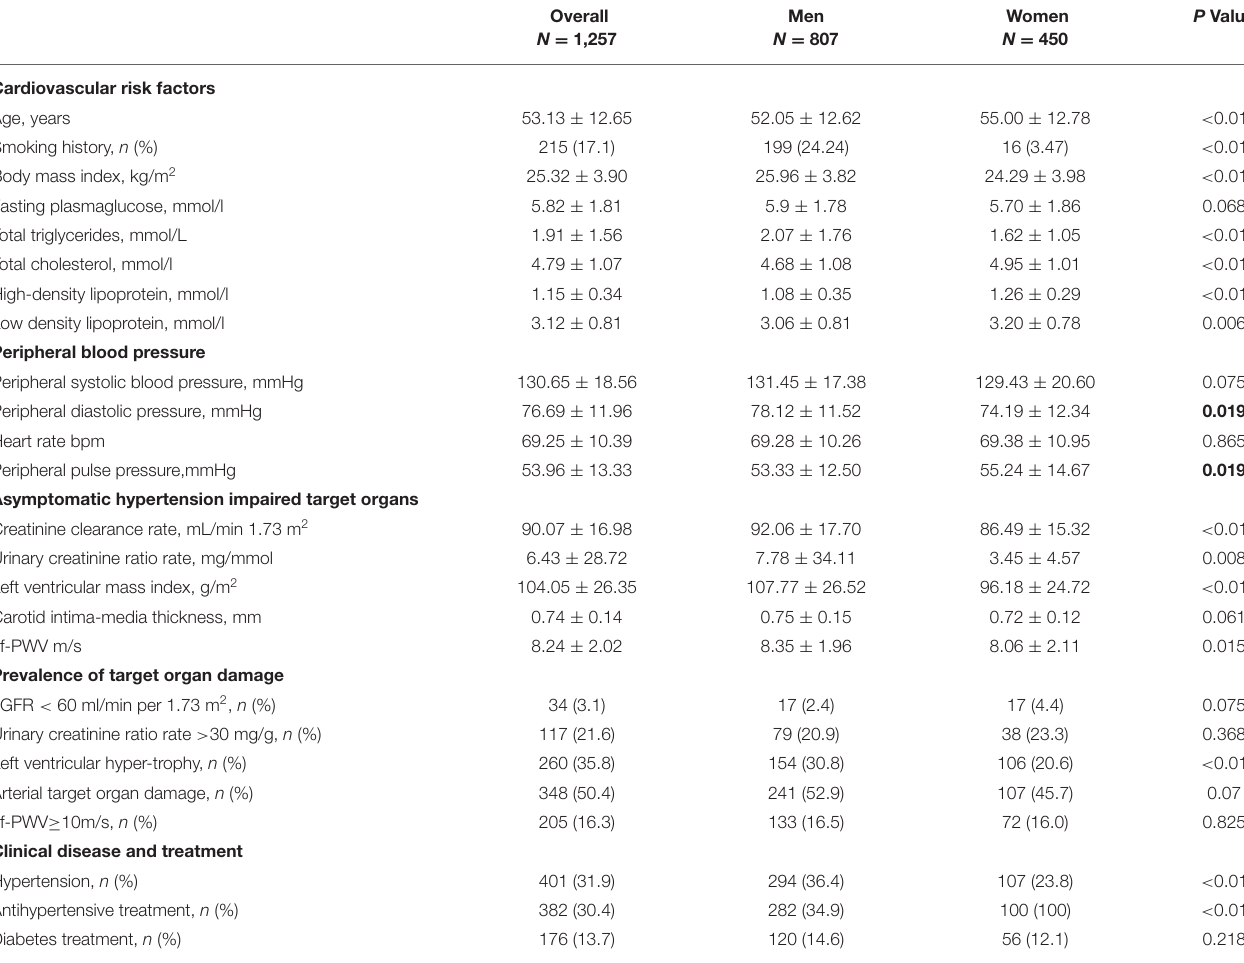
TABLE 1 | Baseline characteristics of participants by